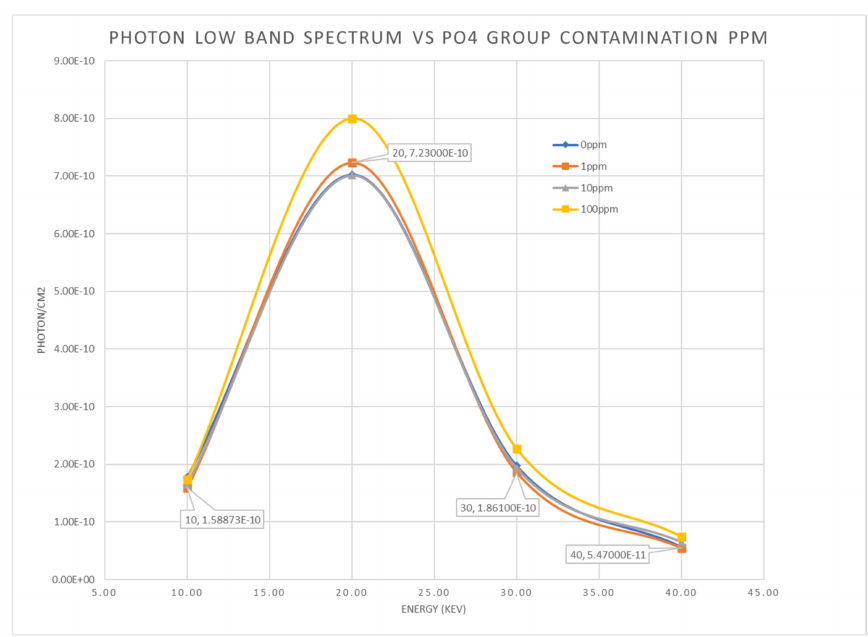
Figure 12. Low band photon spectrum B-air sample vs. contamination.